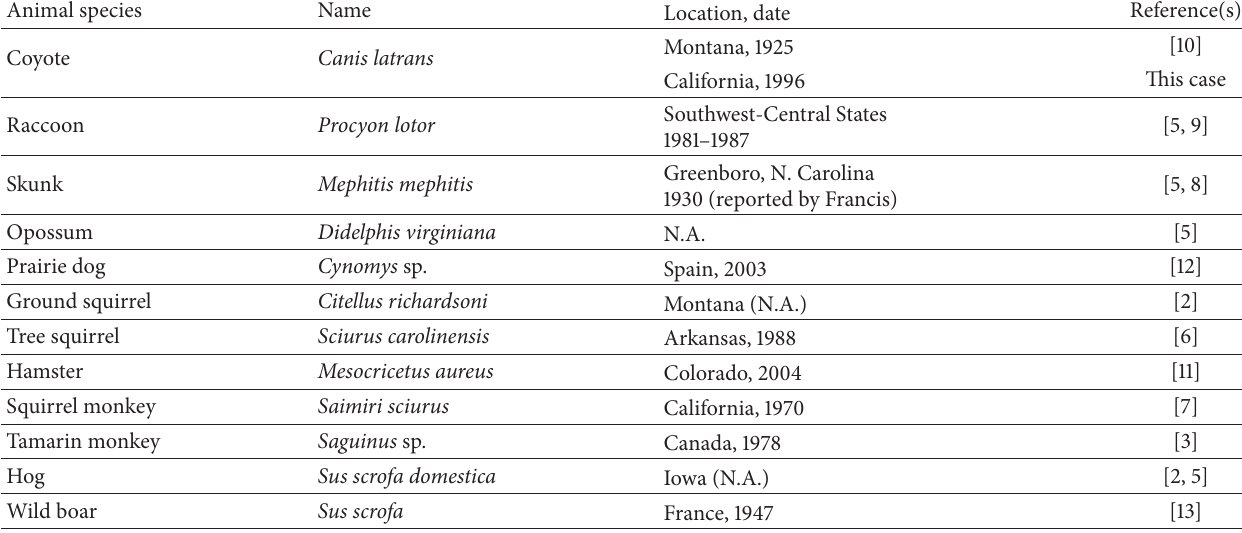
Table 1: Reported cases of tularemia in humans following an animal bite (excluding cats and